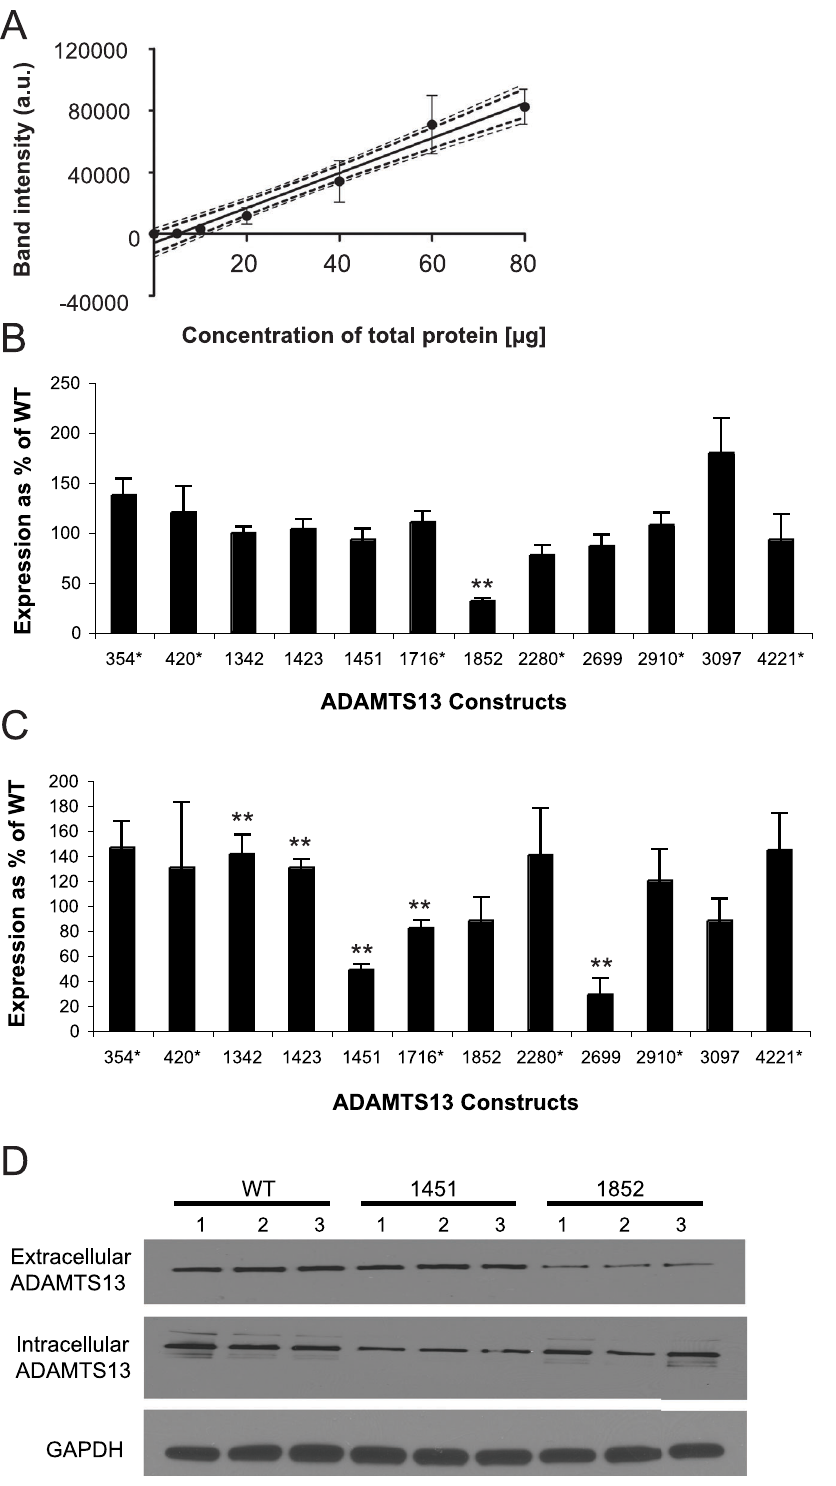
Figure 2. Exvivo analysis of expression levels of ADAMTS13 variants. A. Western blotting data revealing linear dependence between the amount of the loaded protein and the western signal: Media was collected and concentrated 24 h. post-transfection. Increasing amounts of total protein (5, 10, 20, 40, 60 and 80 m g) were subjected to SDS-PAGE analysis. Anti-V5 antibody was used to detect ADAMTS13 and densitometry analysis was performed as described in Materials and Methods. The dashed bolded lines indicate 95% confidence limits and the dashed non-bolded lines represent 90% confidence limits. B. Extracellular ADAMTS13 Expression (based on immunoblot analysis). Expression results for each variant are presented relative to WT. Multiple independent transfection experiments utilizing each variant and WT ADAMTS13 construct were performed (**p- value , 0.05). C. Intracellular ADAMTS13 Expression (based on immunoblot analysis): GAPDH and/or b -actin were used as loading controls (not shown). Expression results for each variants are presented relative to WT. Multiple independent transfection experiments utilizing each variant and